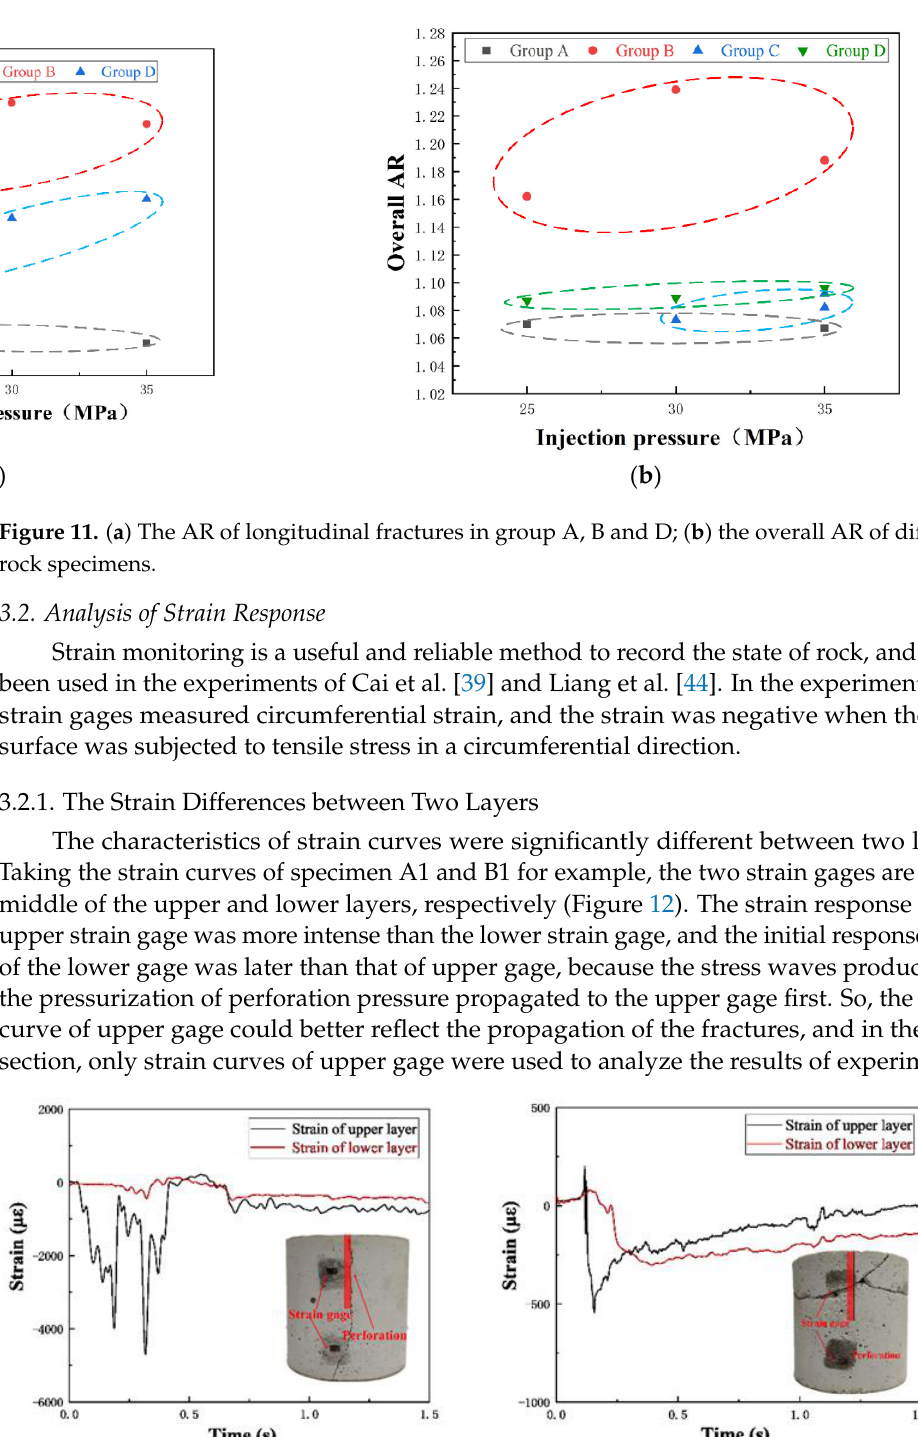
( b ) Figure 13. Typical experimental results of strain curve during fracturing. ( a ) Hard rock (specimen A1) and ( b ) soft rock (specimen B2).